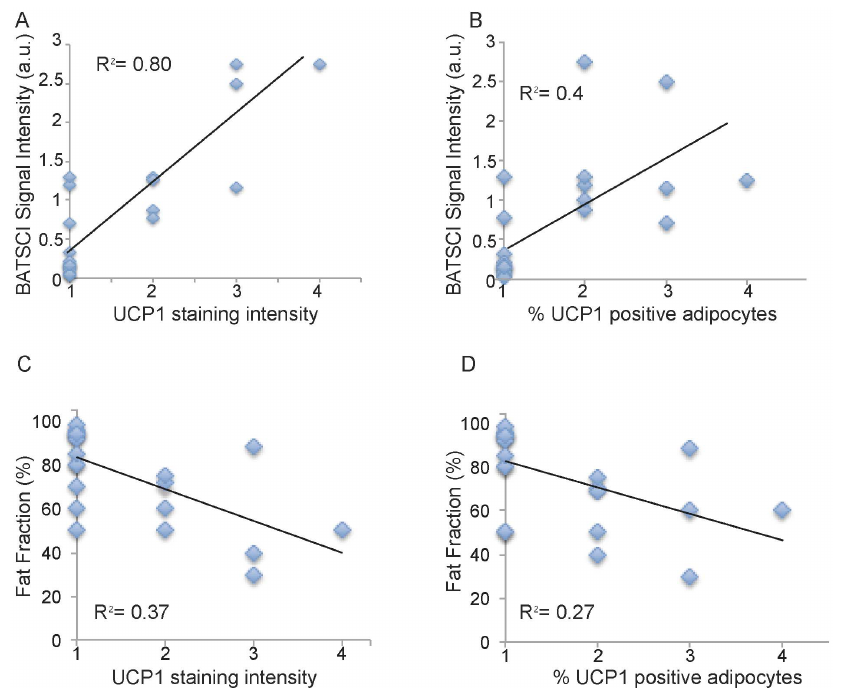
Figure 8. Correlation between BATSCI signal intensity and UCP1 expression. ( A ) Scatter plot showing the correlation between intensity of UCP1 staining and normalized BATSCI signal intensity (r-square=0.8, p , 0.0001). ( B ) Scatter plot showing correlation between % of adipocytes tissue stained positive for UCP1 and normalized BATSCI signal intensity (r square=0.4, p , 0.003). ( C ) Scatter plot showing the correlation between intensity of UCP1 staining and tissue fat fraction (r-square=0.37, p , 0.016). ( D ) Scatter plot showing correlation between % of adipocytes tissue stained positive for UCP1 and tissue fat fraction (r square=0.27, p , 0.0015).